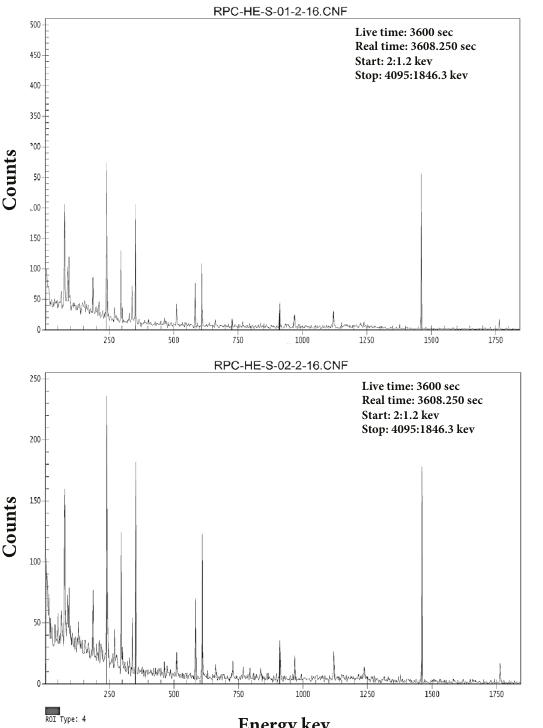
Figure 3: The number of counts as a function of energy of the radionuclides in samples 1 and 2, obtained by HPGe detector, and analyzed through Genie 2k Canberra software.